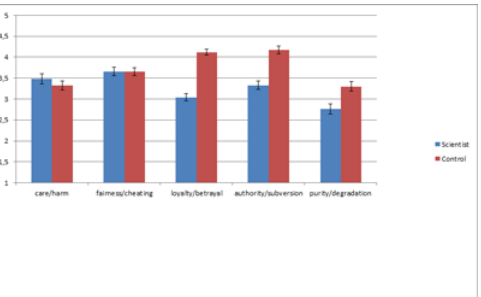
Fig 2. Perceived endorsement of moral foundations by scientist versus control target, scored on 5-point scales ranging from 1 ( strongly disagrees ) to 5 ( strongly agrees ), controlling for perceived atheism of scientists. Differences were significant for loyalty/betrayal, authority/subversion, and purity/ degradation (all ps < .01). Error bars show standard errors of the